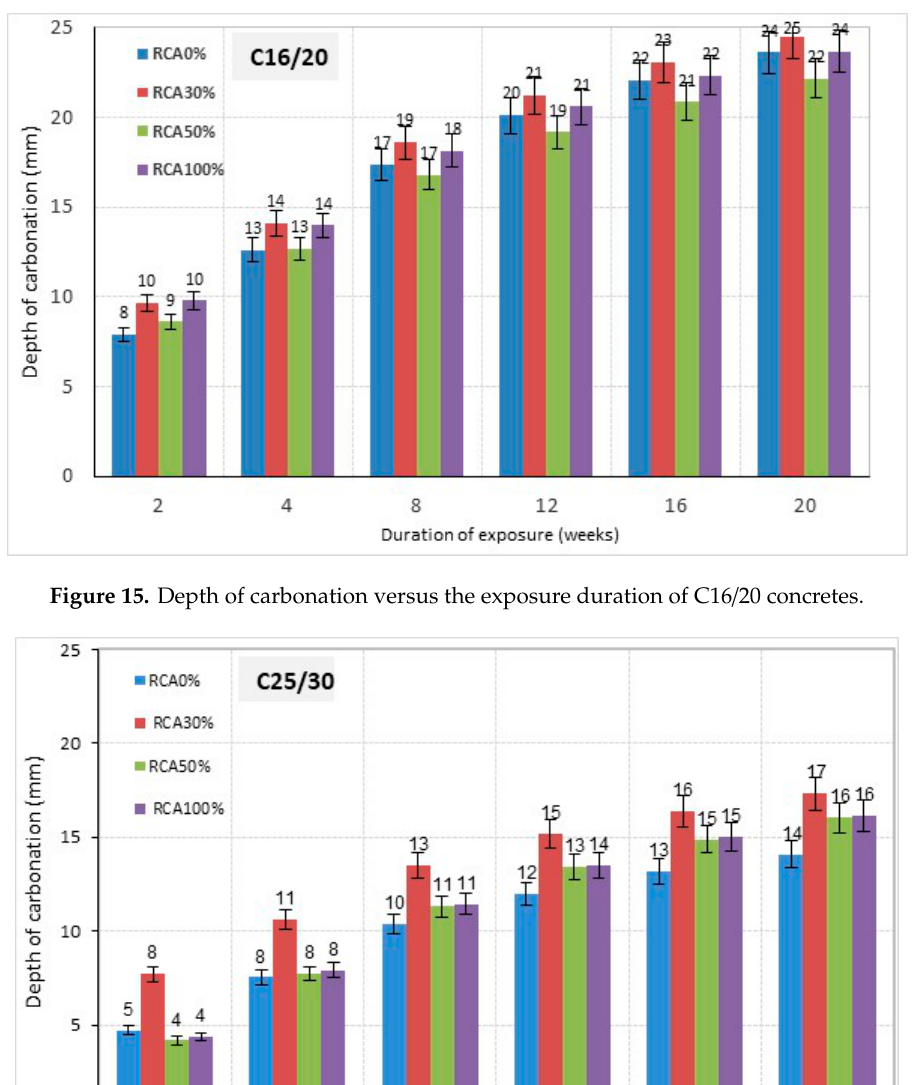
Figure 14. Effect of RCA proportions in the mix on the ISA ‐ 10 of concrete.